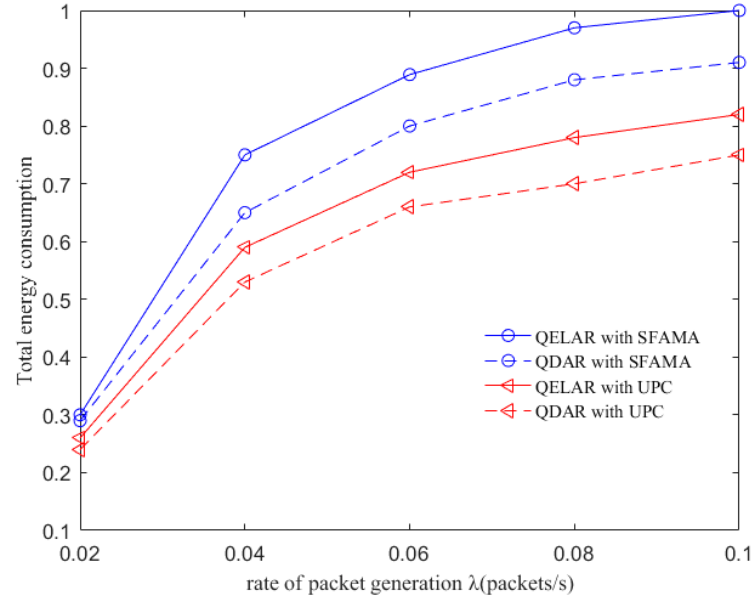
Figure 7. Total energy consumption between QDAR and QELAR with different MAC protocols.